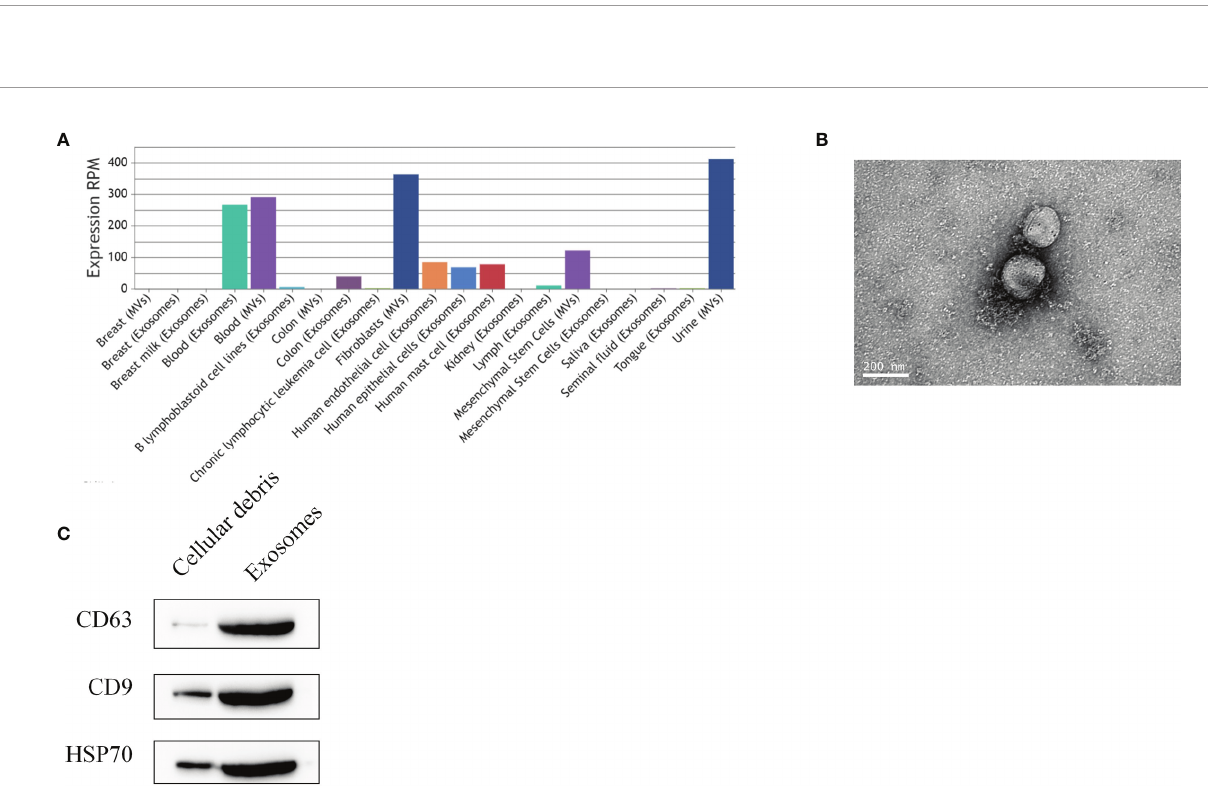
FIGURE 7 | Identi fi cation of exosomes. (A) hsa-miR-139-5p expression of extracellular vesicles; (B) Transmission electron microscopy observation of exosomes; (C) Western blot detection of exosomal surface marker proteins of